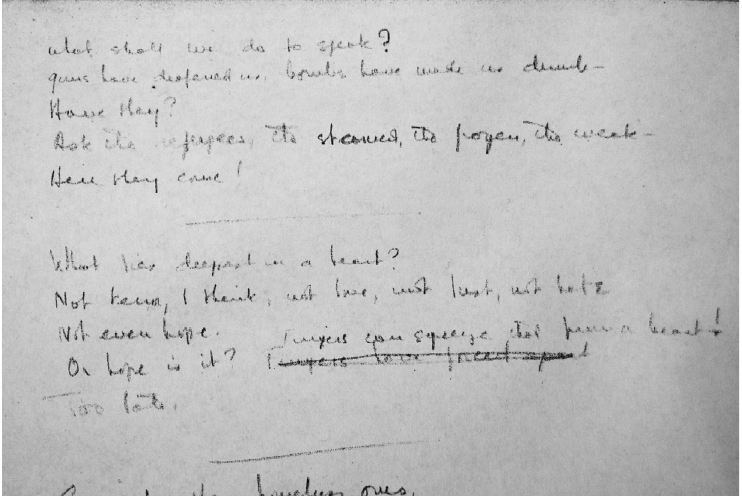
Figure 4 The endpaper of Muriel Rukeyser’s A Turning Wind , with notes in Ackland’s hand for a poem about refugees. Photograph © 2020 Liz